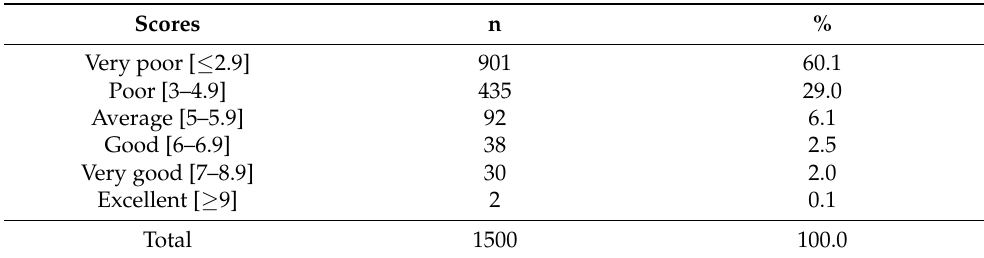
Table 4. Distribution of the students’ scores.